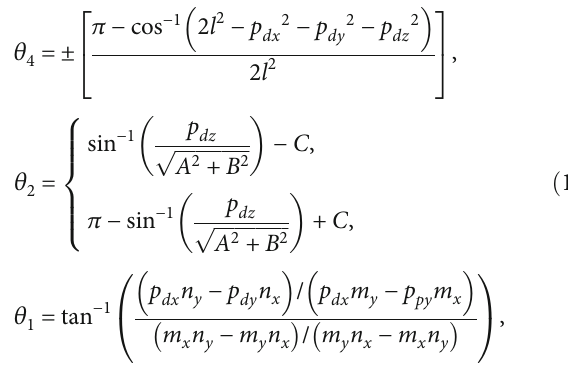
Figure 3: Optimal trajectory of the 12 th neighborhood member. The light green trajectory is the track of the “ subsatellite point ” of the chaser on the ENVISAT. The dark green cuboids denote the chaser